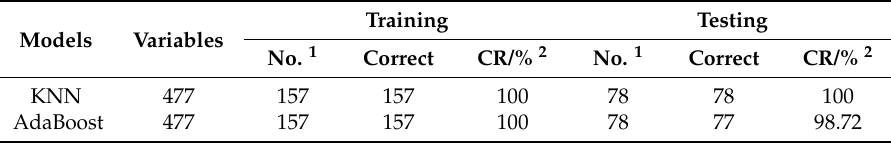
Table 2. Classification results based on spectral information.